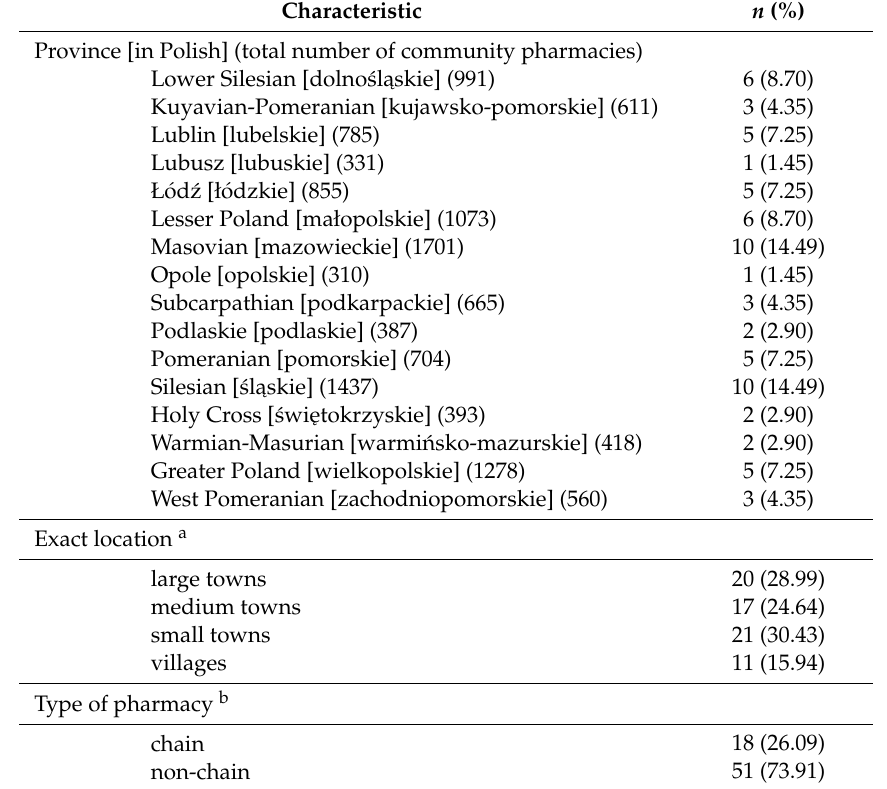
Table 1. Characteristics of randomly chosen community pharmacies.